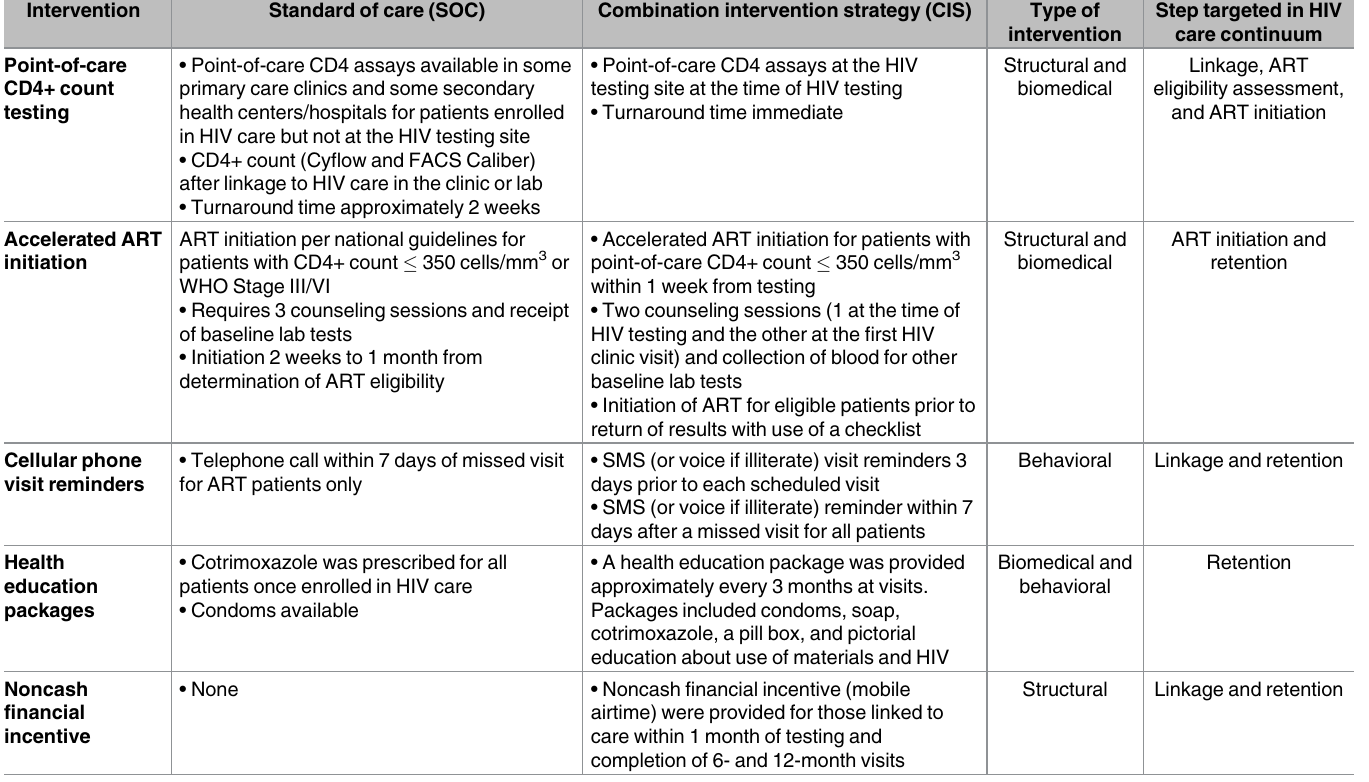
Table 1. Comparison of combination intervention strategy(CIS) to standard of care (SOC)